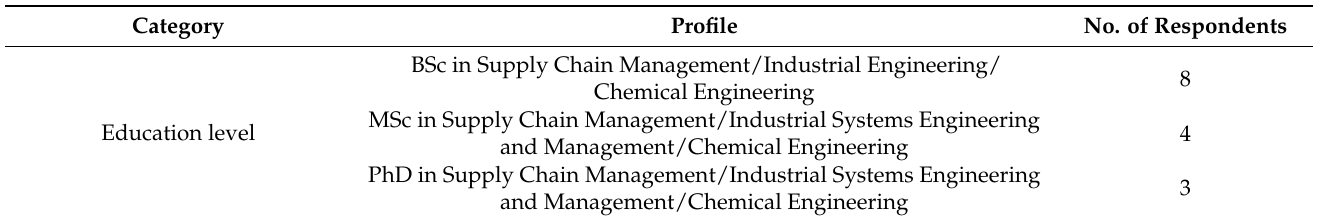
Table 5. The professionals